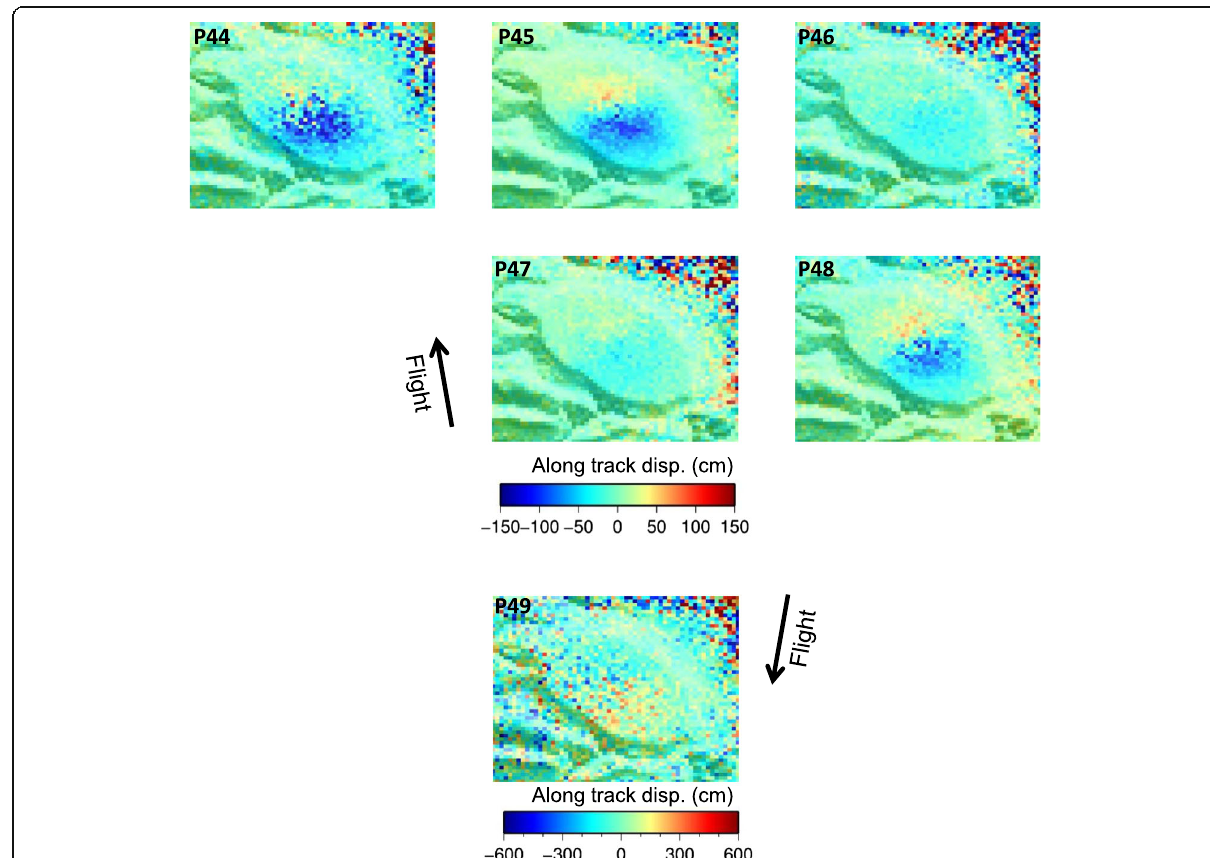
Fig. 8 Observed MAI data derived from ALOS-2/PALSAR-2 ascending track data (path 176, frame 800, P44 – 48) and descending track data (path 71, frame 2800, P49). Details of each data set are described in Table 4